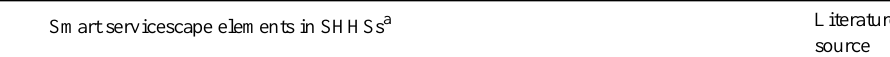
Table 1. Smart servicescape elements in smart homes for health care